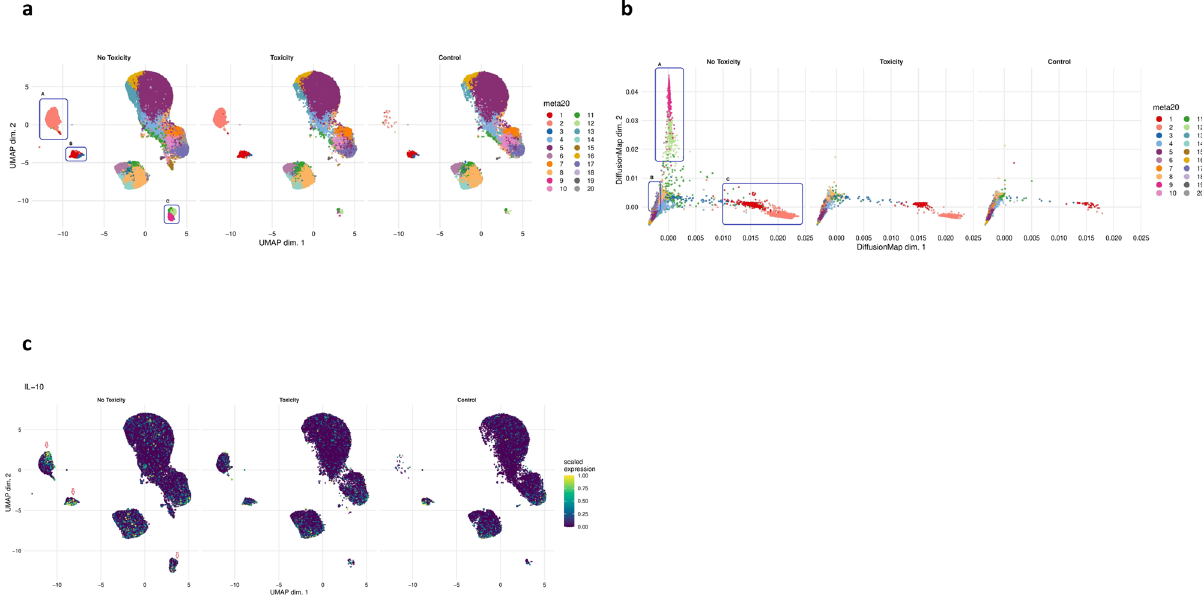
Fig. 3 Comparative dimensionality reduction plots identify de fi ciencies of speci fi c B-cell population in toxicity patients ( n = 46). a UMAP plots strati fi ed according to condition, “ no toxicity ” , “ toxicity ” and “ healthy controls ” . Clusters highlighted by blue boxes correspond to clusters 1, 2, 3, 9 and 12 identi fi ed from Fig. 2a. These clusters are attenuated in the “ toxicity ” cohort in this unsupervised analysis. The box labelled “ A ” is encircling cluster 2 (peach). The box labelled “ B ” is encircling clusters 1 (red) and 3 (blue). The box labelled “ C ” is encircling clusters 9 (pink) and 12 (light green). All samples are randomly downsampled to account for equally representative populations across samples. b Diffusion map strati fi ed according to condition, “ no toxicity ” , “ toxicity ” and “ healthy controls ” . Clusters highlighted by blue boxes correspond to clusters 1, 2, 9, 12, 17 and 18 identi fi ed from Fig. 2a. These clusters are attenuated in the “ toxicity ” cohort in this unsupervised analysis. The box labelled “ A ” is encircling clusters 9 (pink) and 12 (light green). The box labelled “ B ” is encircling clusters 17 (deep lilac) and 18 (light lilac). The box labelled “ C ” is encircling clusters 1 (red) and 2 (peach). All samples are randomly downsampled to account for equally representative populations across samples. c UMAP plots strati fi ed according to overall population IL-10 expression and by condition. Expression is largely con fi ned to the Breg clusters demarcated by the red arrows. Matched IL-10 expression in the corresponding clusters in the toxicity patients is reduced. Although cluster 2 (peach island in ( a )) is IL-10-negative in the heatmap, this is based on median marker expression and therefore does not illustrate the cell-to-cell variability in functional IL-10 status. The left-hand most red arrow depicts cluster 2 with subpopulations of IL-10 expressing cells (areas of light green and yellow), said cells are not seen in the corresponding cells in the toxicity